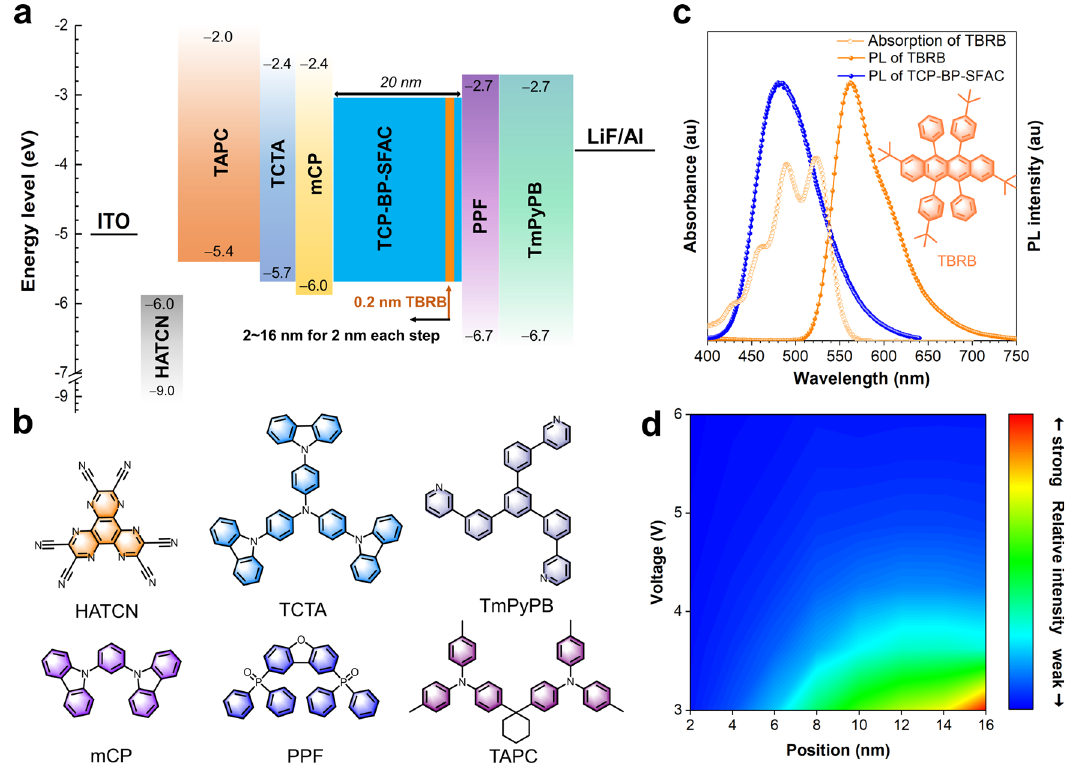
Fig. 3 | Device data for detecting exciton recombination zone. a Device con- fi guration forexciton recombination zone detecting. b Molecularstructures of the functional materials applied in WOLEDs. c Absorption and PL spectra of TBRB in